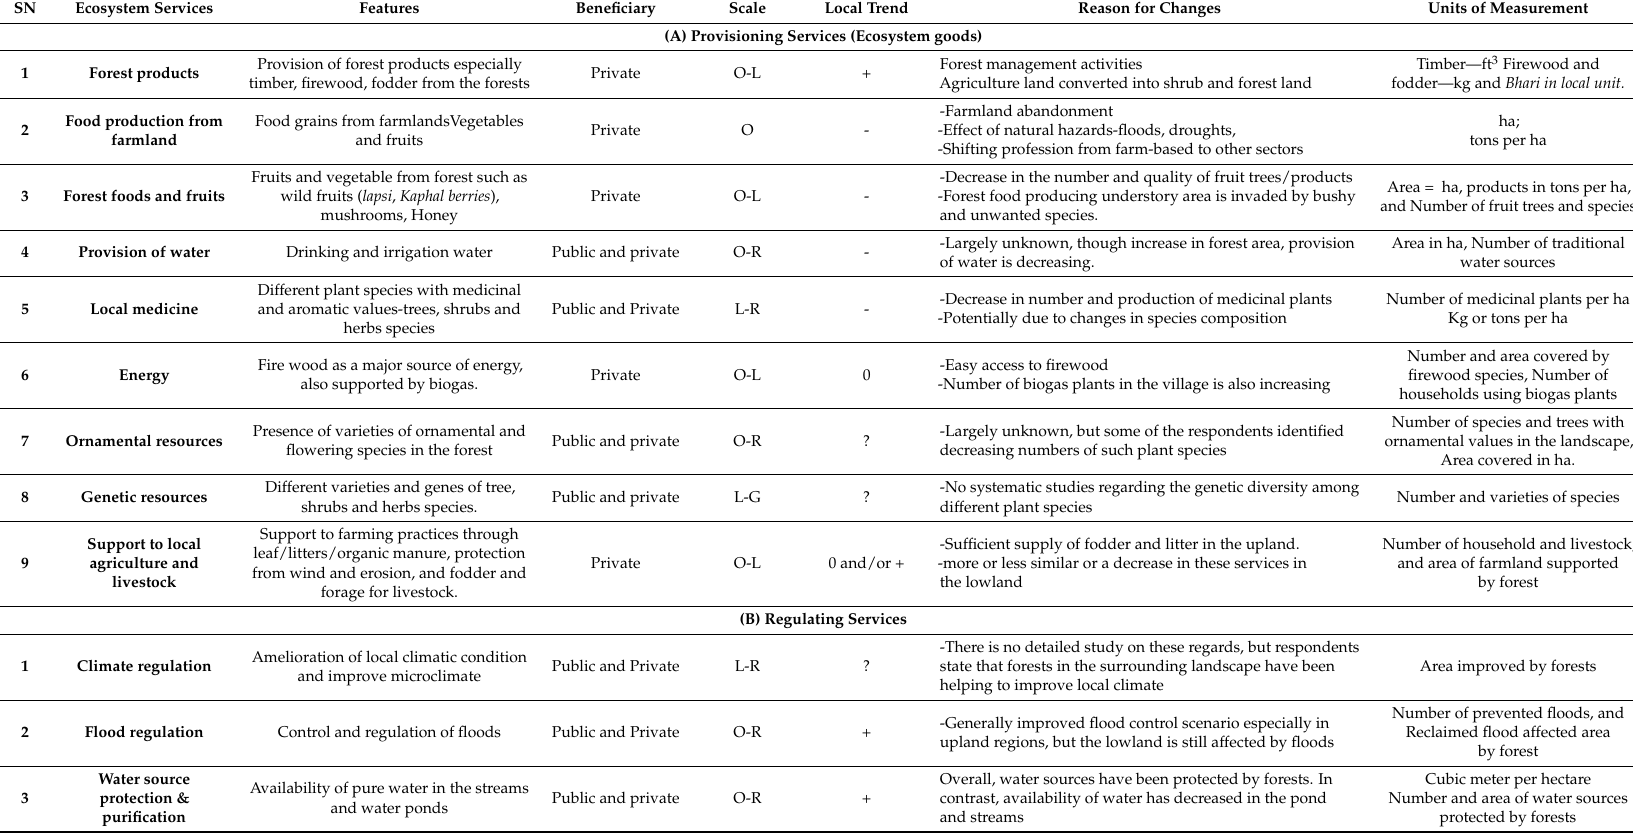
Table 1. Major ecosystem goods and services (ES) in Panchase Mountain Ecological Region (PMER), Western Nepal based on (Baral et al., 2014 [30]; Bennett et al., 2009 [31]; Dobbs et al., 2014 [32]; Paudyal et al., 2015 [5]). In which, Beneficiary; Private = individual household, Public = public benefit throughout the community and beyond; Scale, O = onsite users—living with in the forest surroundings, L = local users—living quite nearby the forest within 5 km, R = regional users—living between 5–300 km, N = national users, G = Global users beyond national boundaries; on scale, ‘+’ = increasing, ‘0’ = no change, ‘-’ = decreasing, and ? = unknown; key measurement units, “no” = number, ML = mega liters, tons = metric tons (1000 kg), ha = Hectare, Bhari = local unit equivalent of around 30 kg, per ha = per hectare, kg = Kilogram, ft 3 = Cubic